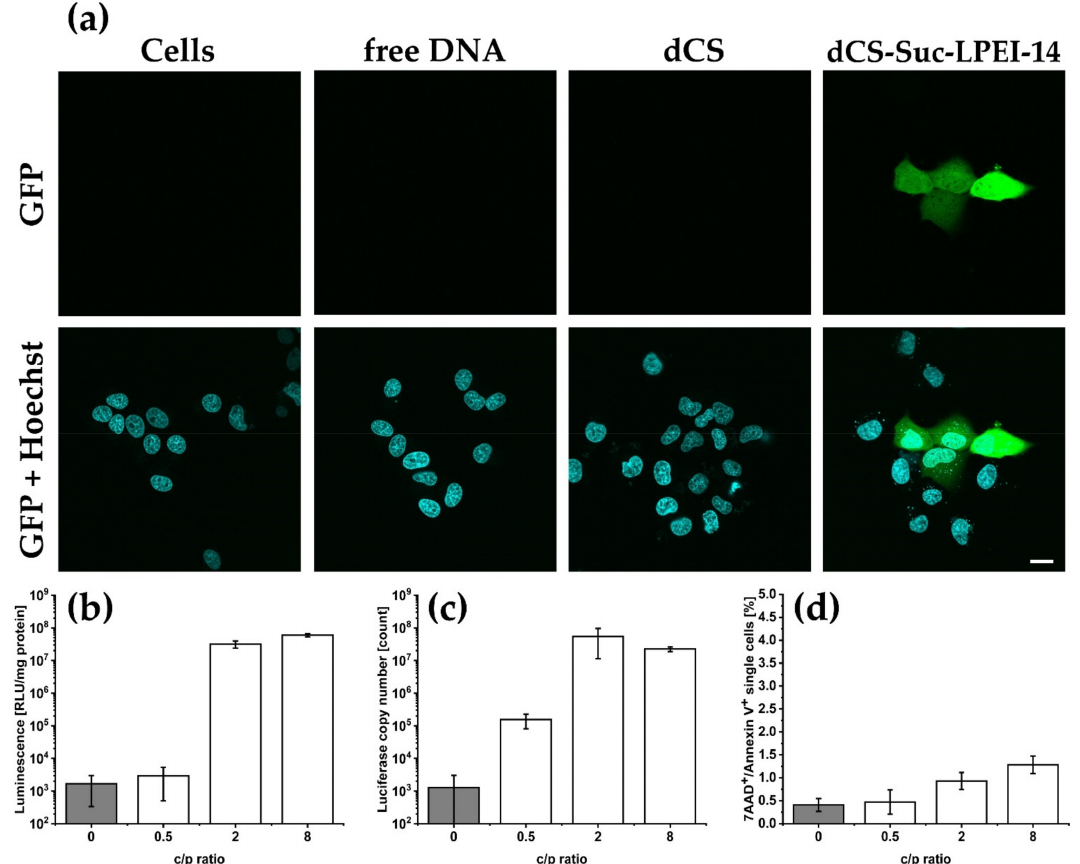
Figure 4. In vitro gene expression and toxicity pattern of the lead candidate. Experiments were conducted using two reporter gene nanovector-DNA (n.CAGLuc2 and n.CAG.GFP1). ( a ) Left Panel: Untreated control cells. Nuclei were stained with Hoechst 33,342 (Blue). Middle Panels: Expression of GFP in HuH-7 cells 48 h after transfection with free DNA and dCS. Right panel: Expression of GFP in HuH-7 cells 48 h after transfection with lead candidate dCS-Suc-LPEI-14 . Scale bar: 20 µ m. ( b – d ) In vitro evaluation of HuH-7 cells at c/p ratios 0 (free DNA), 0.5, 2, and 8: ( b ) quantitative assessment of luciferase expression as a function of c/p ratios. Gene expression of luciferase is based on luciferin conversion. ( c ) Delivery of luciferase reporter genes as determined by quantitative polymerase-chain reaction (qPCR). ( d ) Evaluation of late apoptotic and necrotic cells 48 h after incubation with dCS-Suc-LPEI-14 . Values are means ± SD, n ≥